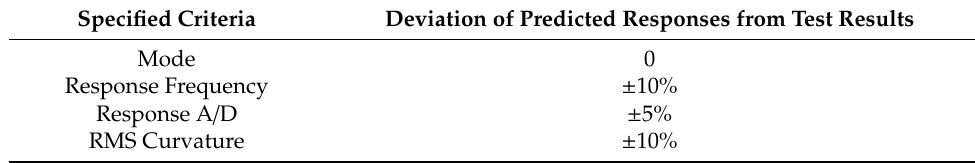
Table 8. Specified criteria for selecting an optimal set of parameters for bare section and buoyancy element.